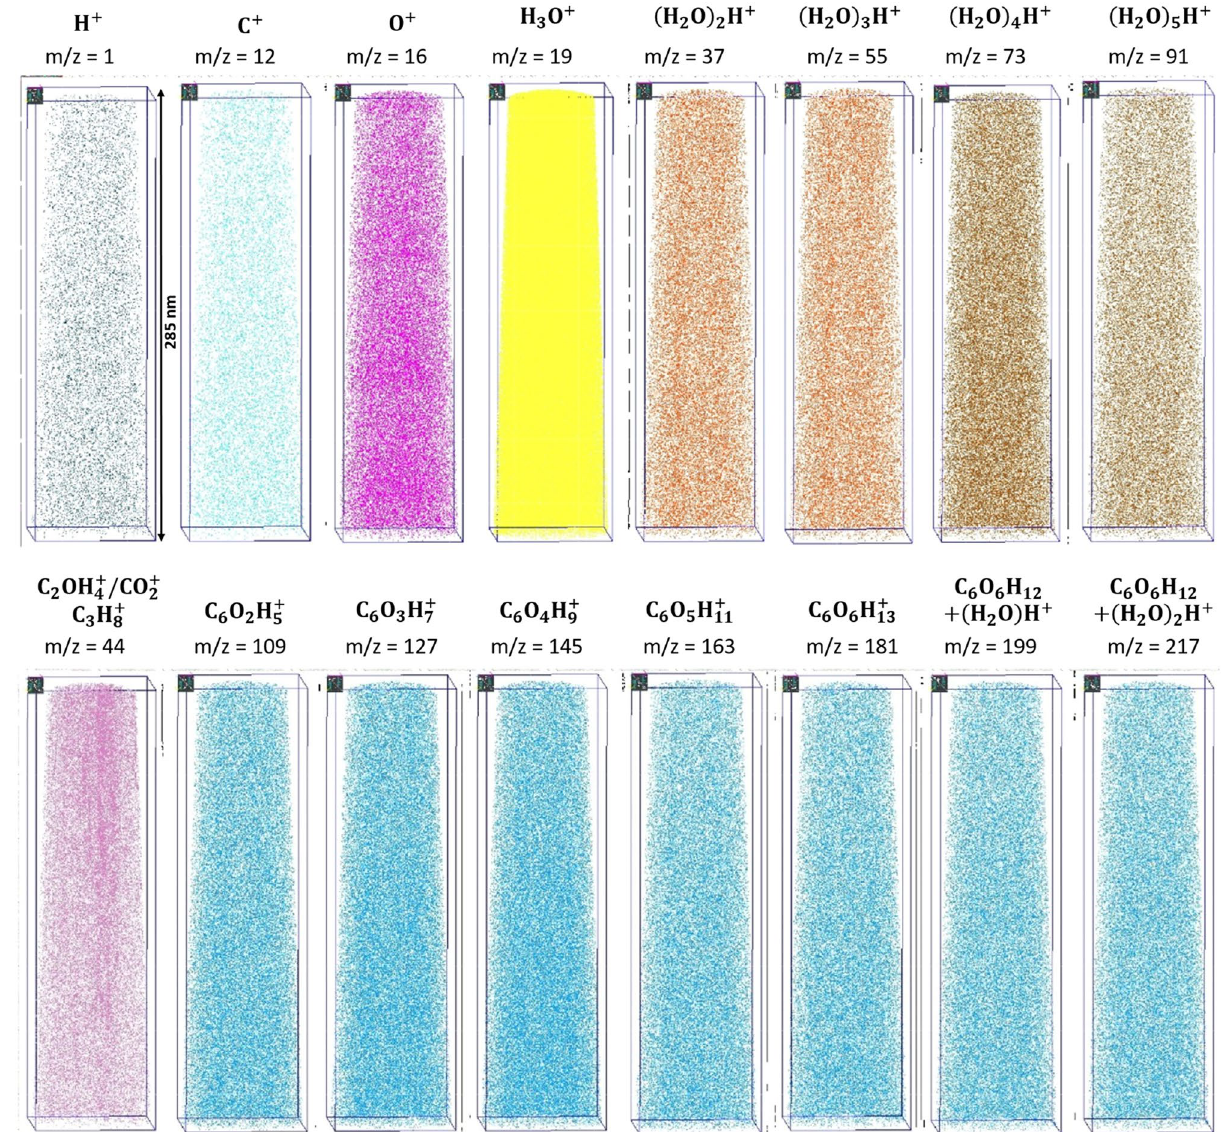
Figure 8. Individual maps of the reconstructed volume for different molecules are